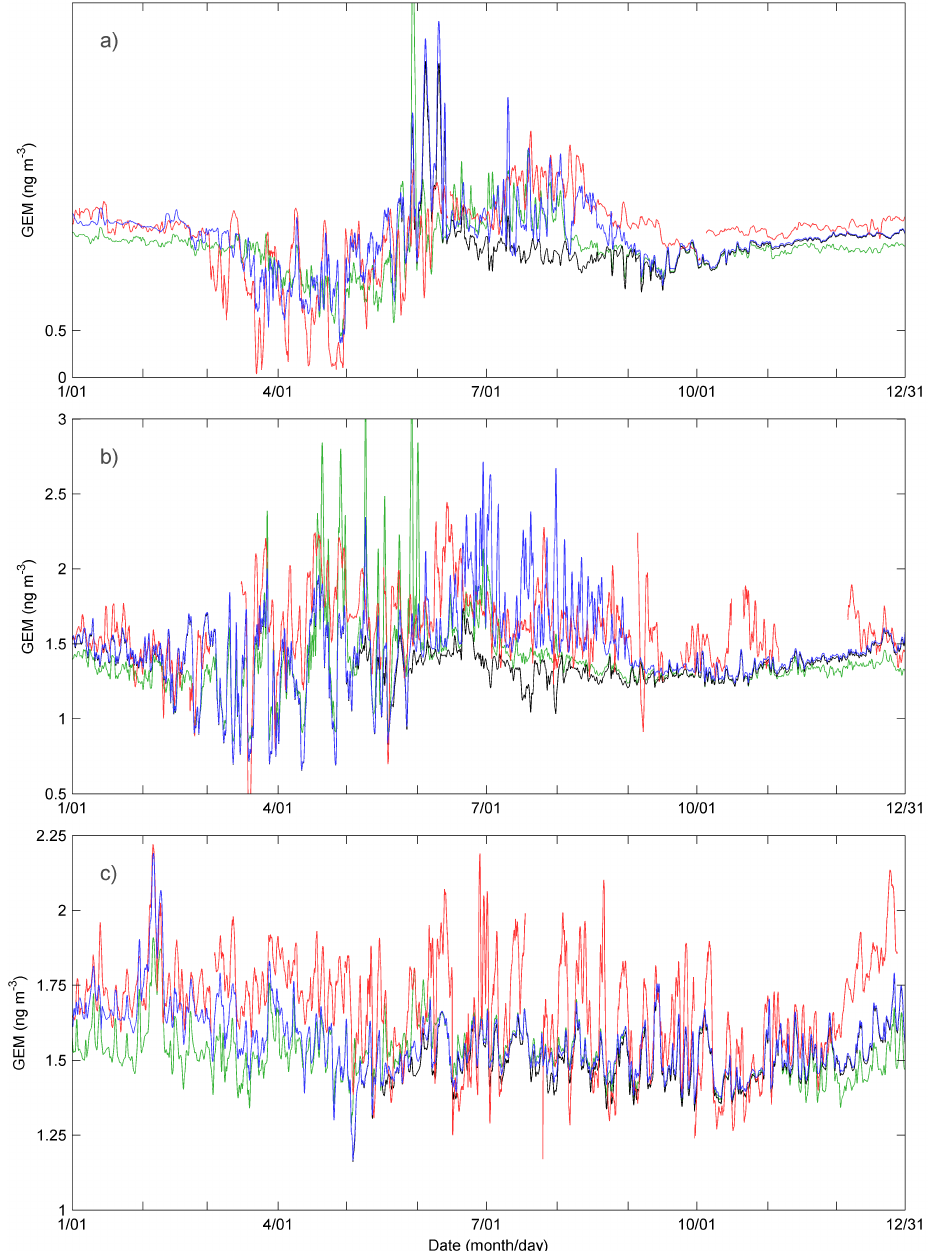
Fig. 3. Presented are time series of concentrations (ng m − 3 ) of surface-level atmospheric GEM at (a) Alert in 2005, (a) Kuujjuarapik in 2007, and (c) Point Petre in 2005 as observed (red) and as simulated by BRun (green), SORun (blue) and SRun